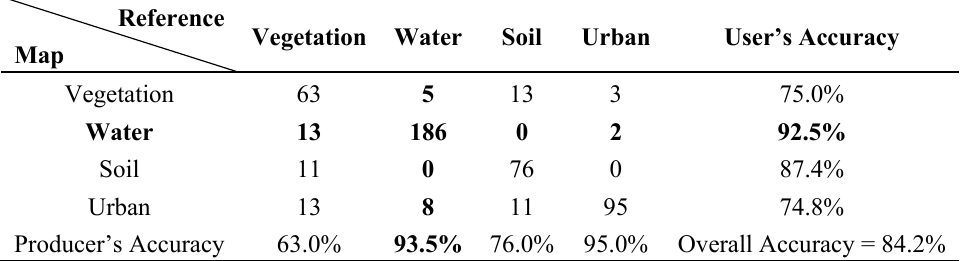
Table 4. Error matrix for after-Katrina classification, Neural Network